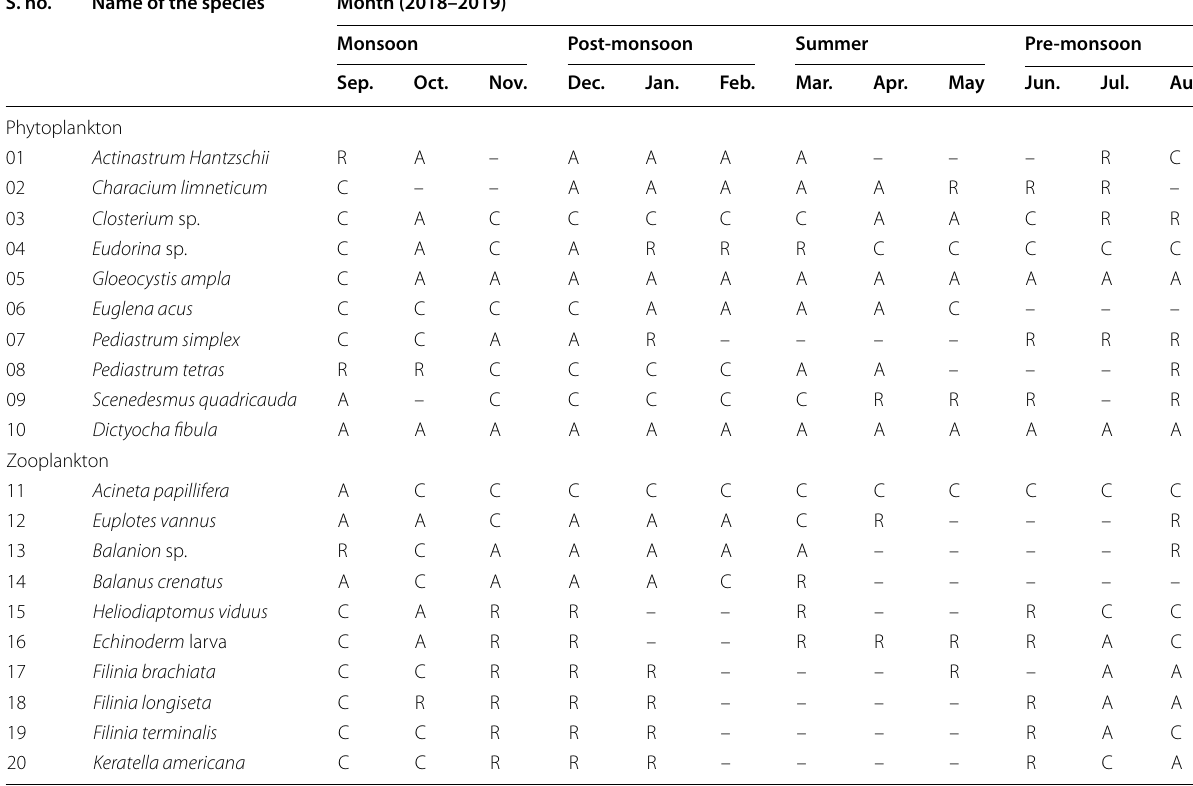
A, Abundance; C, Common; R, Rare; –, Absent